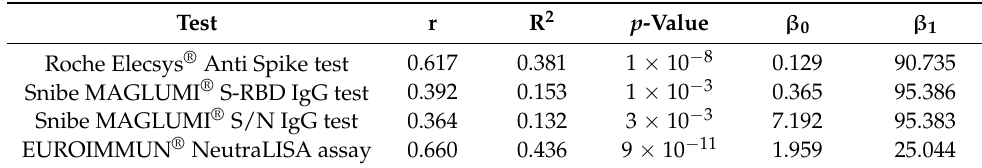
Figure 2. Linear regression analyses related to ( a ) Roche Elecsys ® Anti Spike test, ( b ) Snibe MAGLUMI ® S-RBD IgG test ( c ) Snibe MAGLUMI ® S/N IgG test, ( d ) EUROIMMUN ® NeutraLISA assay. Grey areas represent confidence intervals; black dotted lines represent the linear model. Table 2. Results of the linear regression modeling. r: Pearson’s coefficient; β 0 : slope; β 1 : intercept.